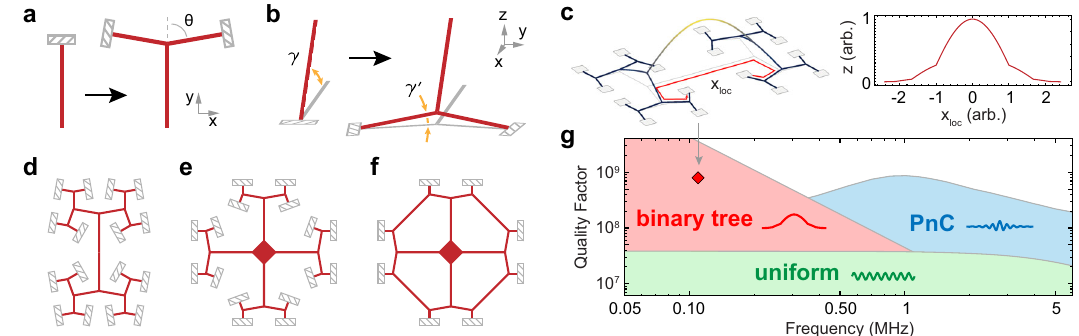
Fig. 1 Construction of hierarchical nanomechanical resonators. a The elementary substitution operation in the hierarchical junction approach and b the effect it produces on the deformation gradients when the structure is deformed out of the xy plane. Dashed rectangles indicate the supports to which the structure is clamped. c Displacement pro fi le of a binary tree beam fundamental mode, displayed in 3D (left), and evaluated along the red path x loc (right). The abrupt mode gradient changes appear due to plotting the mode along a broken line that follows the hierarchy of the branches (red arrow path in the 3D model). As illustrated in the 3D mode pro fi le the displacement undergoes a smooth transition towards the clamping points. Schematic depiction of nanomechanical resonator designs: a binary tree beam ( d ), a trampoline with branching tethers ( e ), and a steering wheel trampoline ( f ). g Diagram of dissipation dilution in stressed resonators. The top boundaries of colored regions indicate the theoretical Q vs. frequency limits for different types of Si 3 N 4 resonators with 20 nm thicknesses and lengths below 3 mm. The red diamond indicates the mode with the highest Q measured in this work.